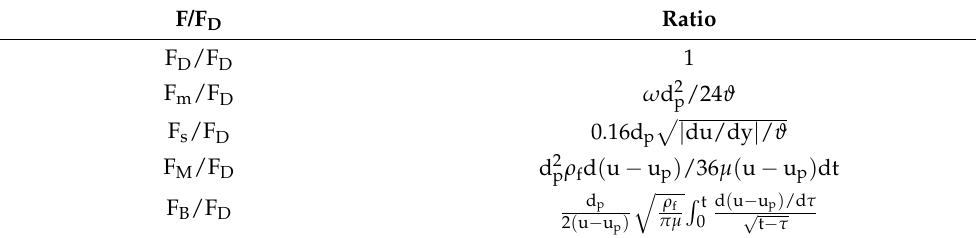
Table 1. The ratio of the forces acting on the particles to the drag